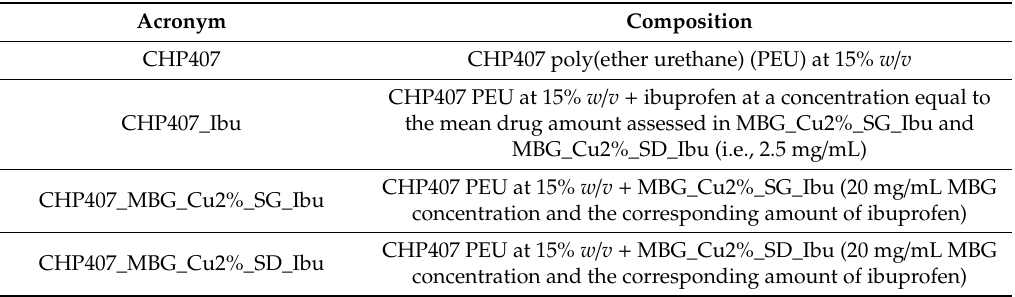
Table 1. Compositional information and acronyms of the designed sol-gel